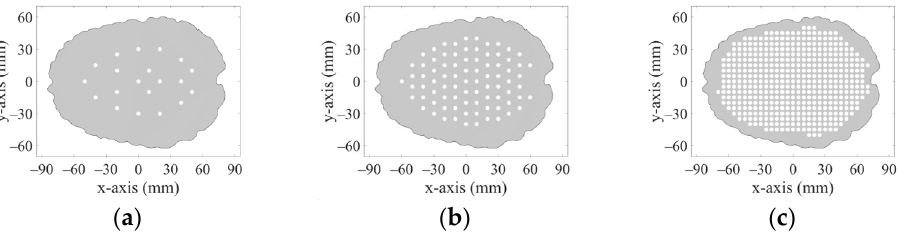
Figure 3. 20 positions ( a ), 83 positions ( b ), and 456 positions ( c ) in the brain where strokes of various sizes were placed.